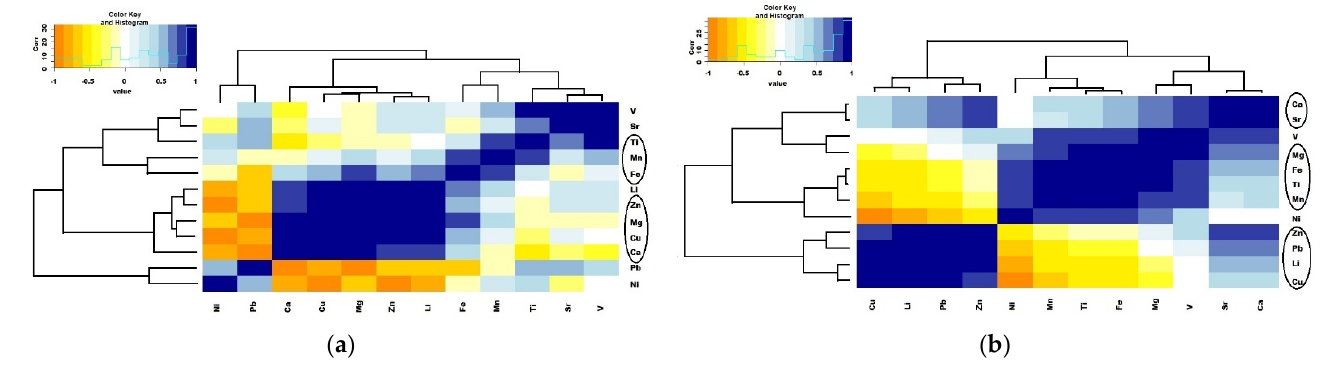
Figure 7. Co-occurrence of metals within integrated sediment fractions: ( a ) bioavailable-oxidized fraction and ( b ) reduced-residual fraction. Distinctive groups are highlighted by circles.